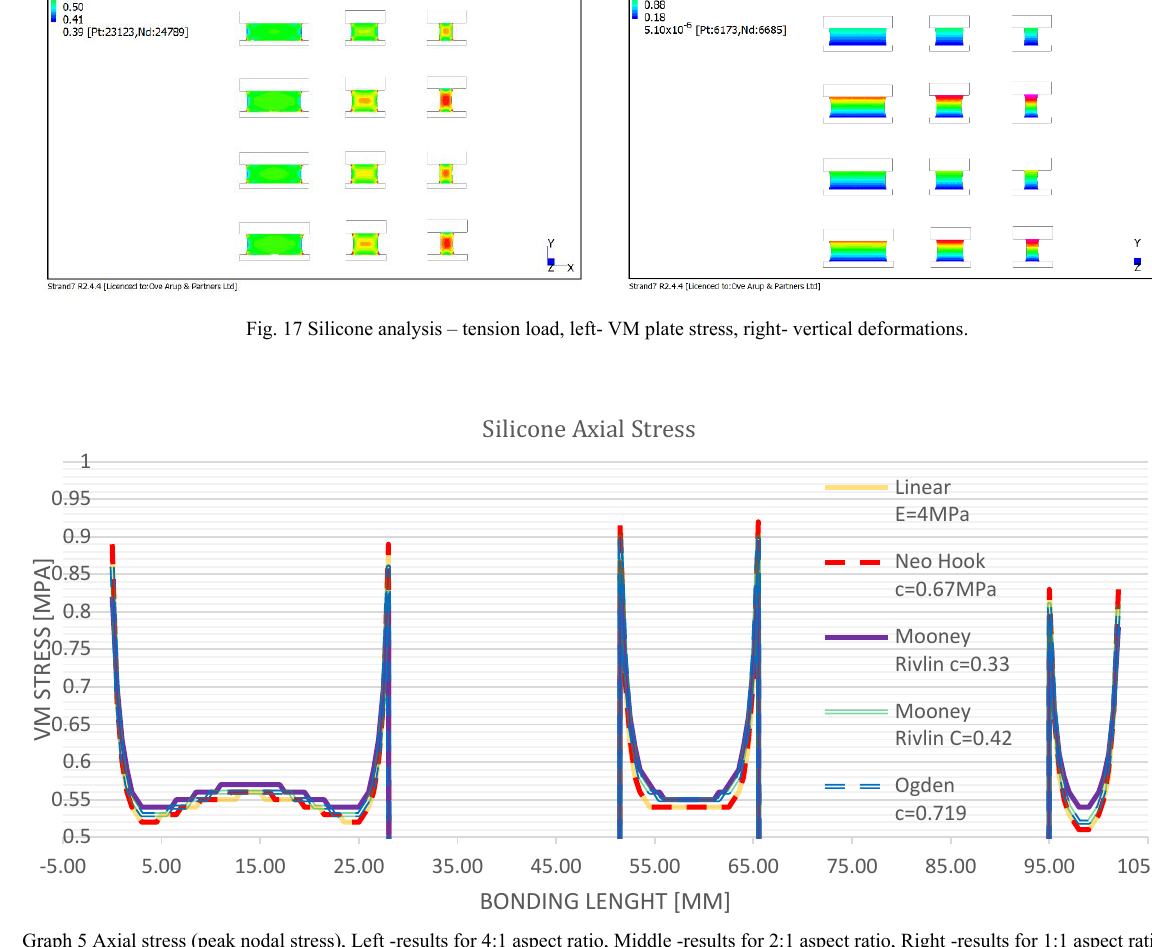
Graph 5 Axial stress (peak nodal stress), Left -results for 4:1 aspect ratio, Middle -results for 2:1 aspect ratio, Right -results for 1:1 aspect